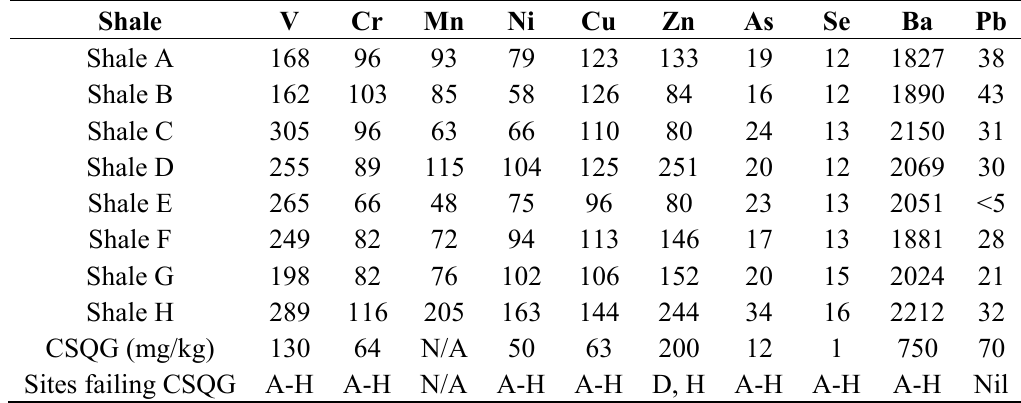
Table 4. Composition of selected trace elements (mg/kg). Canadian Soil Quality Guidelines (CSQG) for the Protection of Environmental and Human Health—Agriculture (2007) [26] are given where available. Concentrations above the CSQG are noted in the final